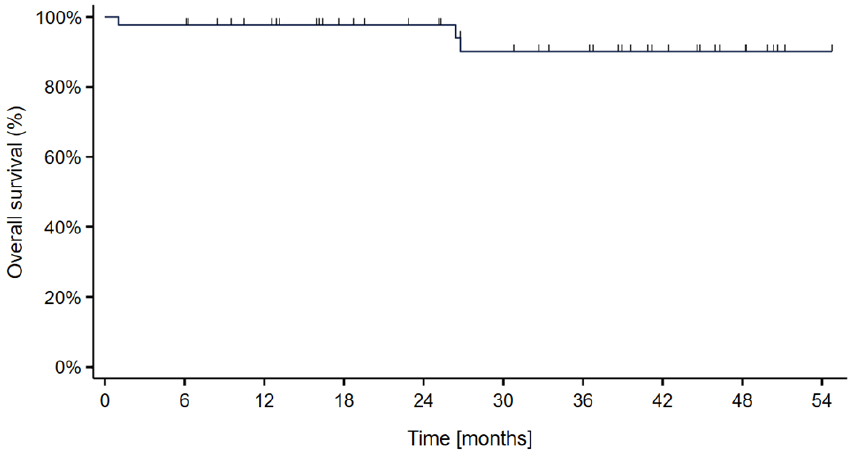
Figure 3. Kaplan – Meier curve showing the overall survival probability in 44 skull-base chordoma Figure 3. Kaplan–Meier curve showing the overall survival probability in 44 skull-base chordoma patients treated with particle therapy at MedAustron. patients treated with particle therapy at MedAustron.